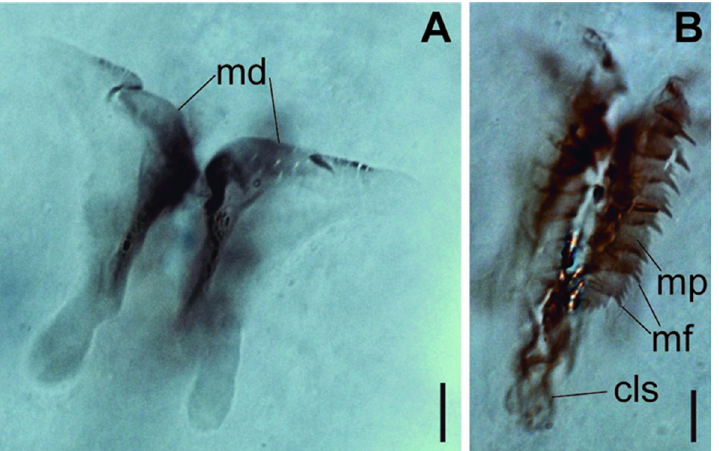
Fig 6. Meiodorvillea minuta (Hartman, 1965), ZUEC-POL. (A) mandibles, dorsal view; (B) maxillae, dorsal view. Abbreviations: md = mandibles; mp = maxillary plates; mf = main fang; cls = carrier-like structure. Scales: (A,B) = 10 μ m.